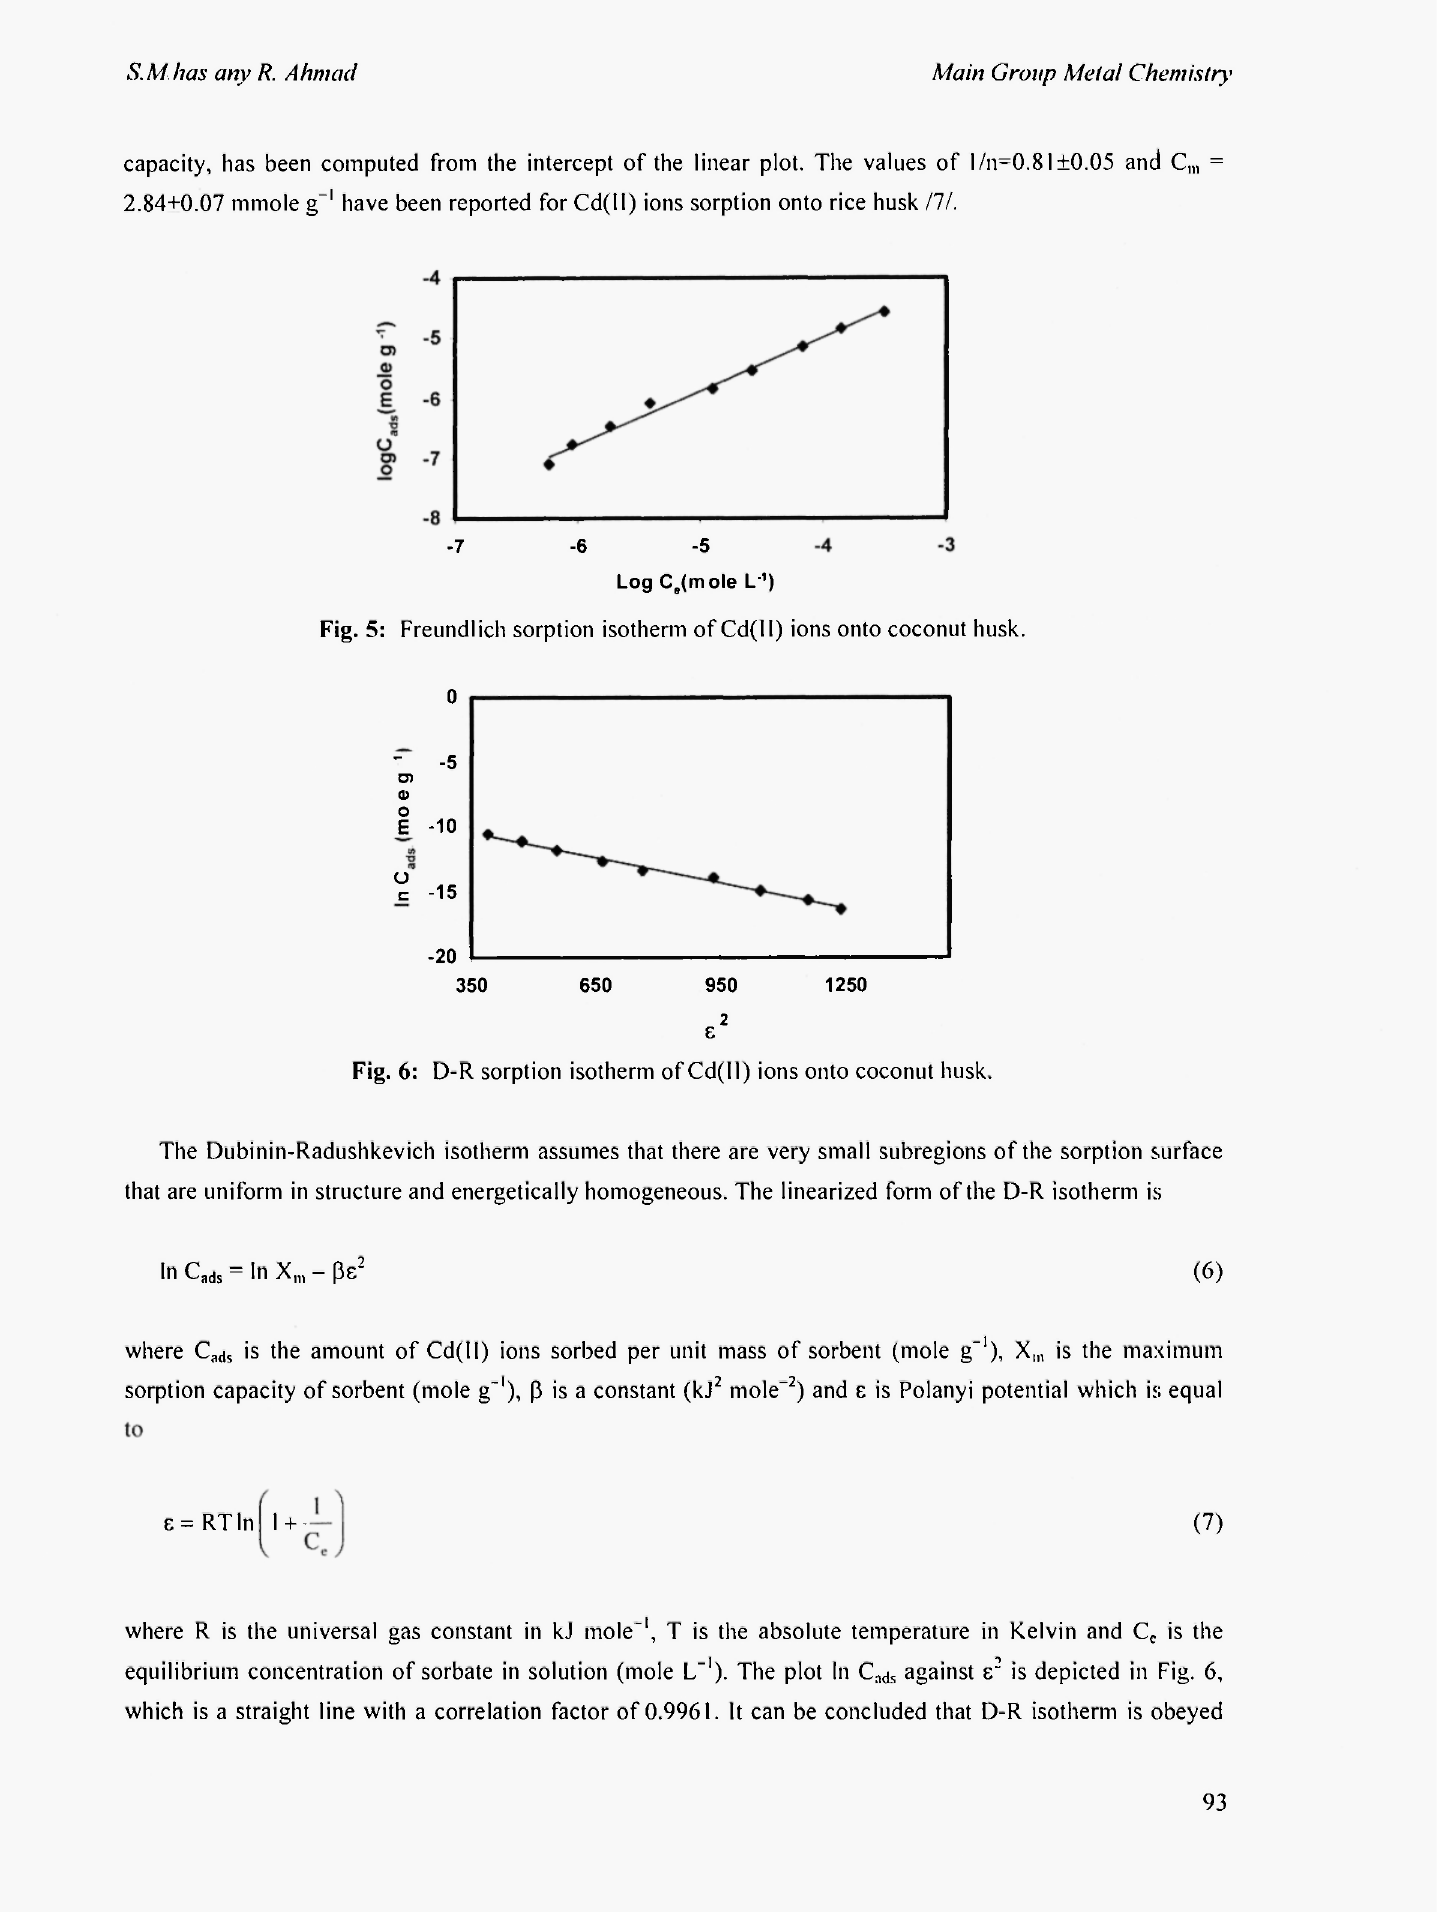
Fig. 5: Freundlich sorption isotherm of Cd (II) ions onto coconut husk.